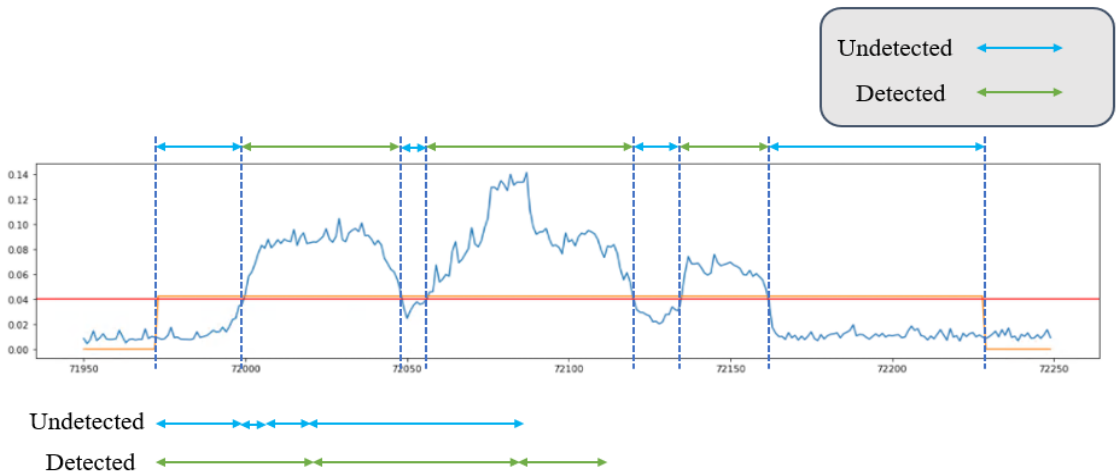
Figure 15. Analysis of detected/undetected attacks for Section 2 (Attack 10).